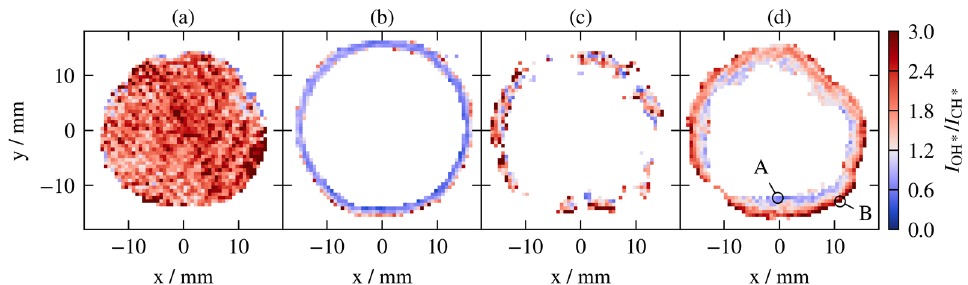
Figure 18. Local intensity ratio of OH* and CH* emission for ( a ) a premixed flat flame, ( b ) a laminar di ff usion flame, ( c ) an instantaneous image of a turbulent di ff usion flame at 1ms exposure time and ( d ) the time average of a turbulent di ff usion flame. The inlet equivalence ratio in all cases is φ = 0.7.